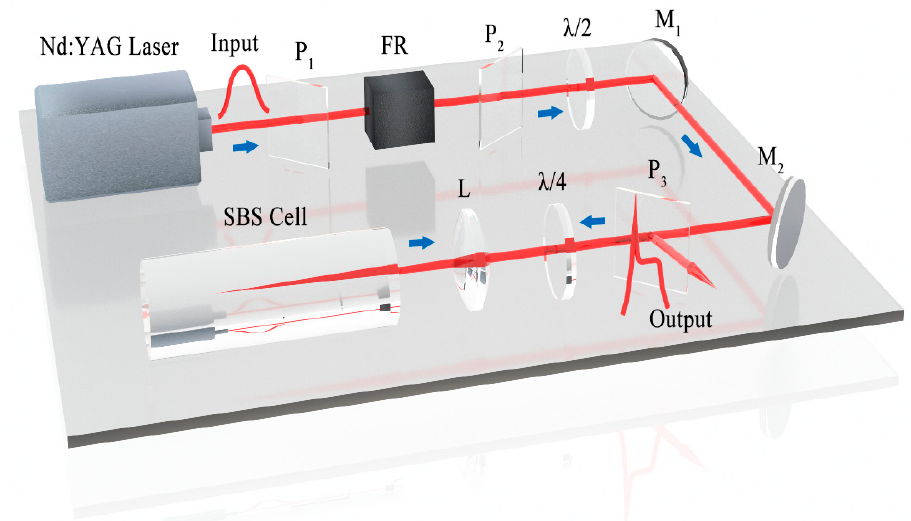
Figure 4. Optical layout for the research on generation of a high-energy temporal step waveform based on SBS waveform shaping. FR, Faraday rotator; P 1 , P 2 , P 3 , polarizers; M 1 , M 2 , high reflective mirrors; L, lens; λ /2, half-wave plate; λ /4, quarter-wave plate.